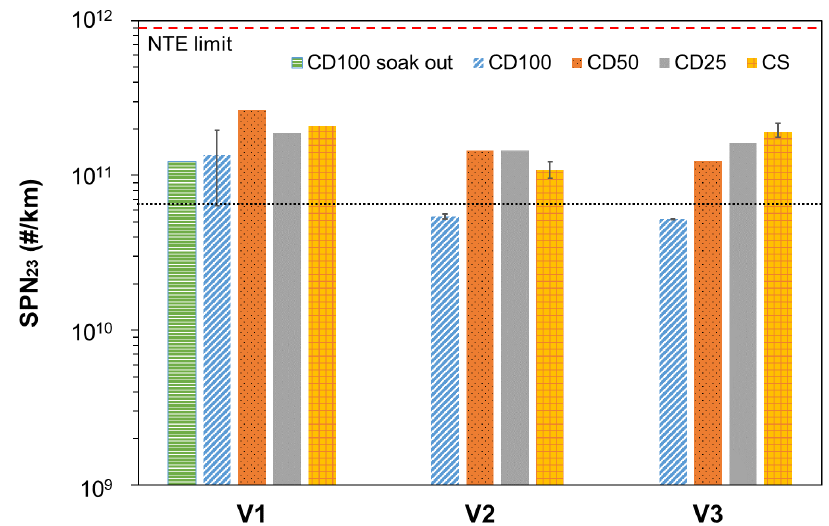
Figure 4. Solid particle number emissions (>23 nm) (SPN 23 ) of three plug-in hybrid electric vehicles (V1 to V3) during the urban part of on-road tests performed according to the European real driving emissions regulation (RDE4). CDx denotes the charge of the REESS; CD100 for 100%, CD50 for 50%, CD25 for 25%. CS stands for trips in charge-sustaining or discharged REESS. The error bars show the maximum and minimum values for tests with more than one repetition. The red dashed line shows the Euro 6 on-road not-to-exceed (NTE) limit (9 × 10 11 #/km) and the black dotted line shows the average urban on-road SPN 23 emissions of eight conventional Euro 6d/6d-TEMP gasoline direct injection vehicles [34].